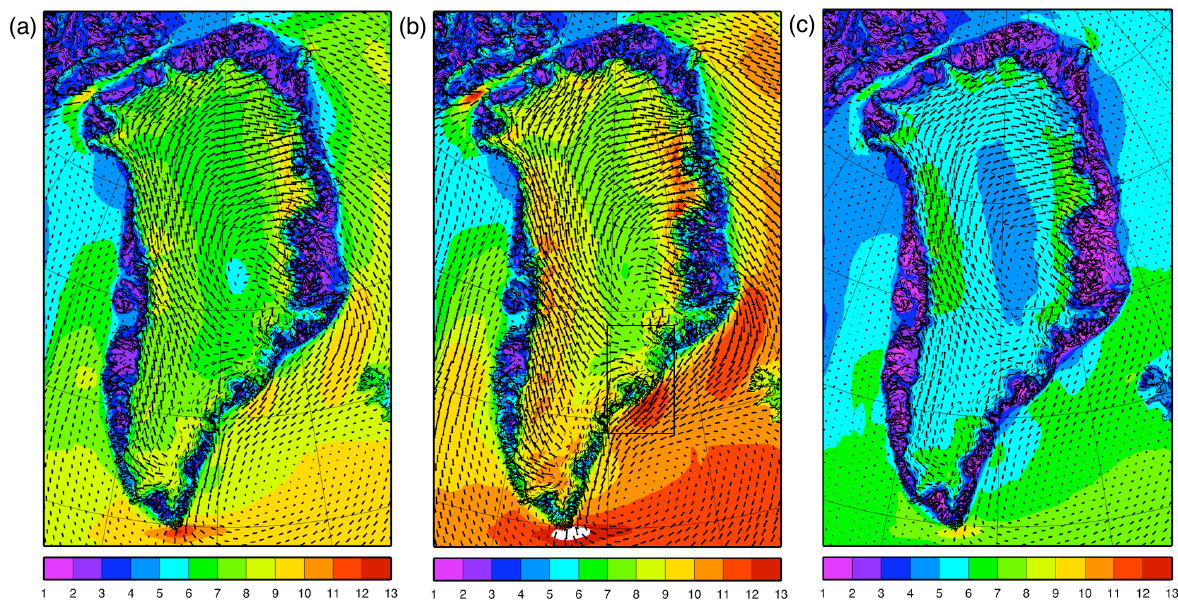
Fig. 2. Averaged 10m wind speed (contours, [ms − 1 ]) and wind vectors over (a) a year, the seasons (b) DJF and (c) JJA. Vectors are plotted every 4 grid points for clarity. Box in (b) indicates region enlarged in Fig. 3b.